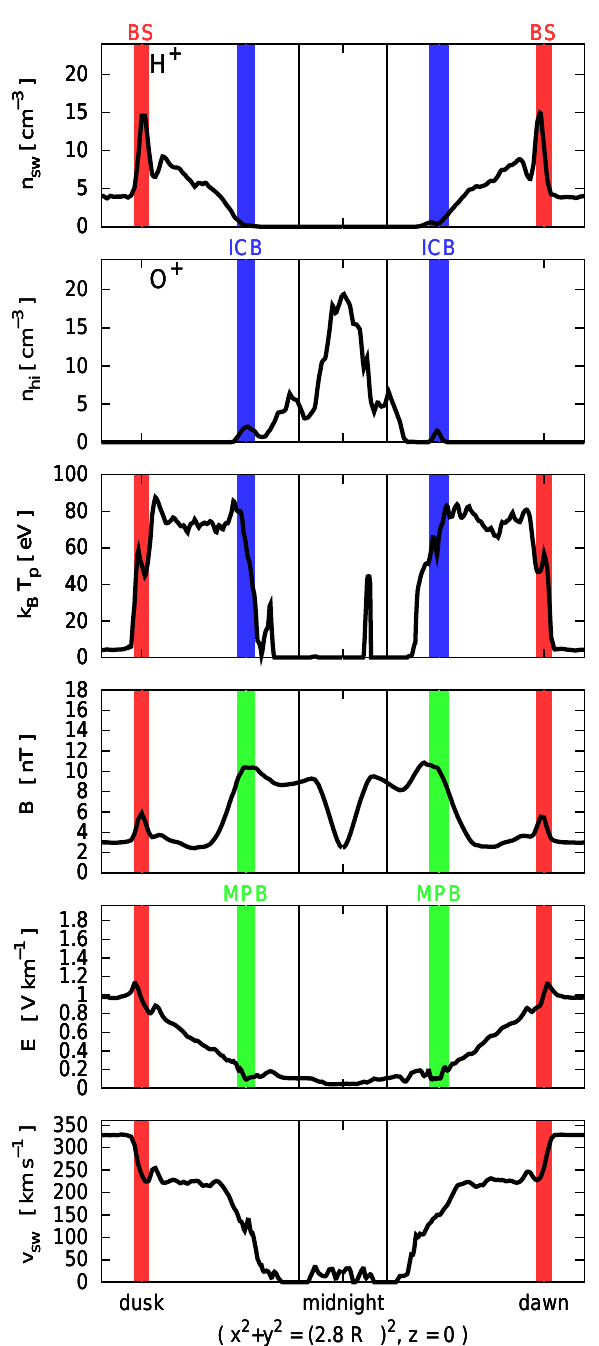
Fig. 12. Simulation results for the “standard run”. Plasma and field parameters along a circular orbit at 2 . 8 R M around Mars in the plane z = 0. This should be compared to the data of the circular Phobos-2 orbit in Fig. 1. The black vertical lines mark the crossing of the optical shadow. The colored bars have the same meaning as in Fig. 11. The heavy ion tail is split up in the plasma sheet with high density and four tail rays with smaller densities (see also Fig. 16c). The near midnight rays are located at the minima of the overall magnetic field. This anti-correlation can also be seen from the observed data of Fig. 1. The proton temperature drops down at the ICB, which is also in agreement with Phobos-2